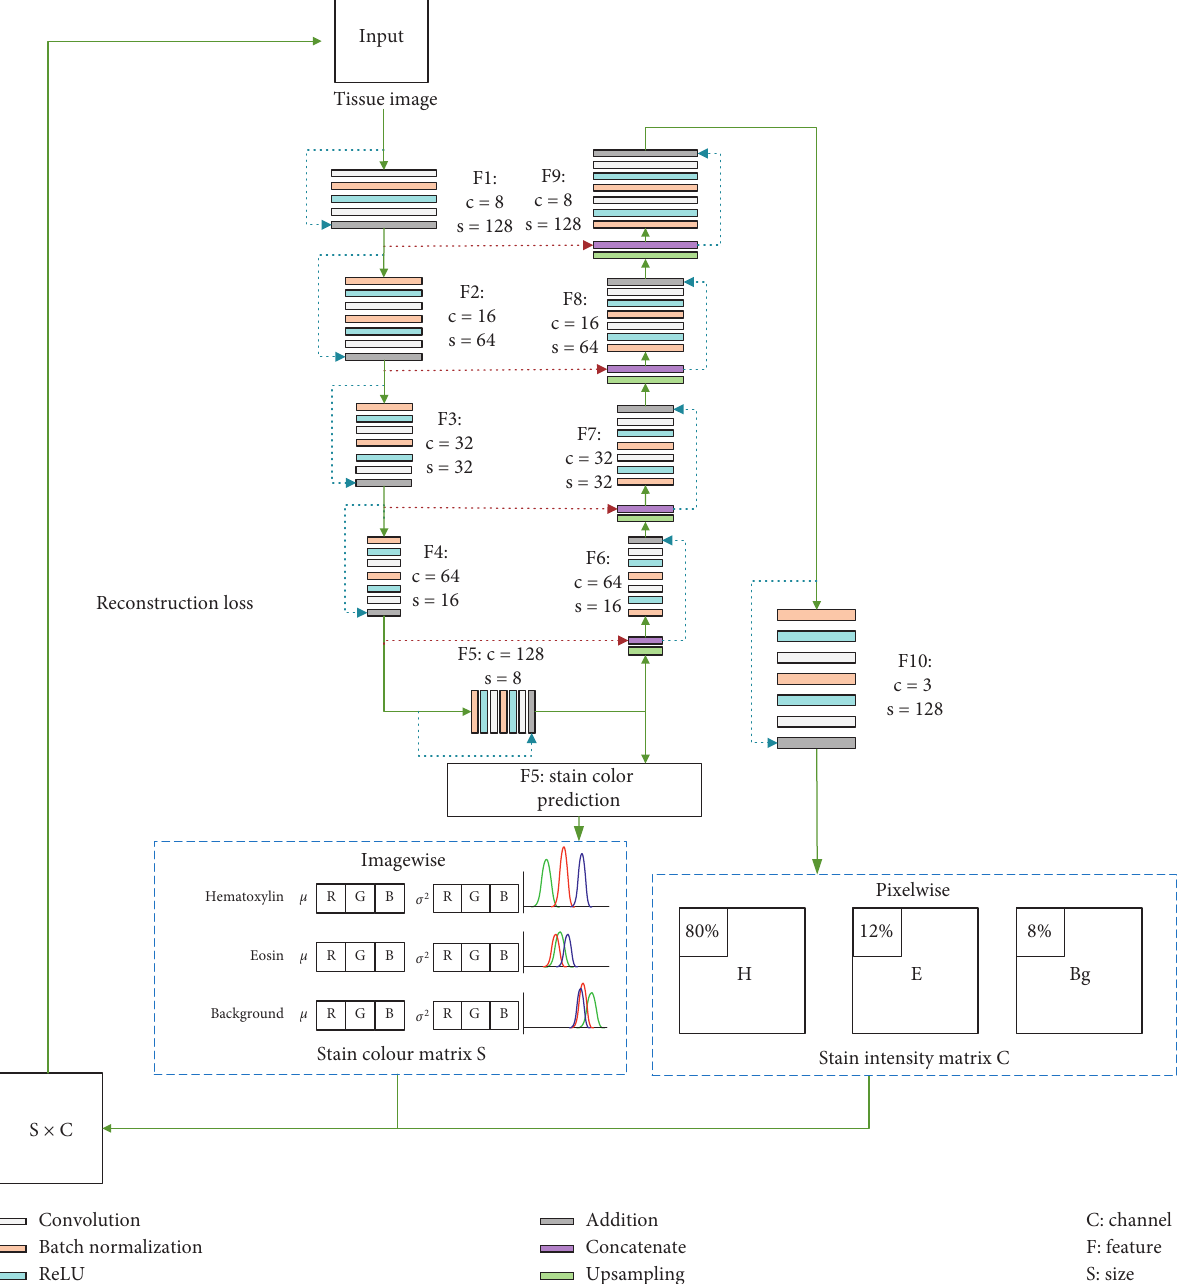
F5: stain color prediction